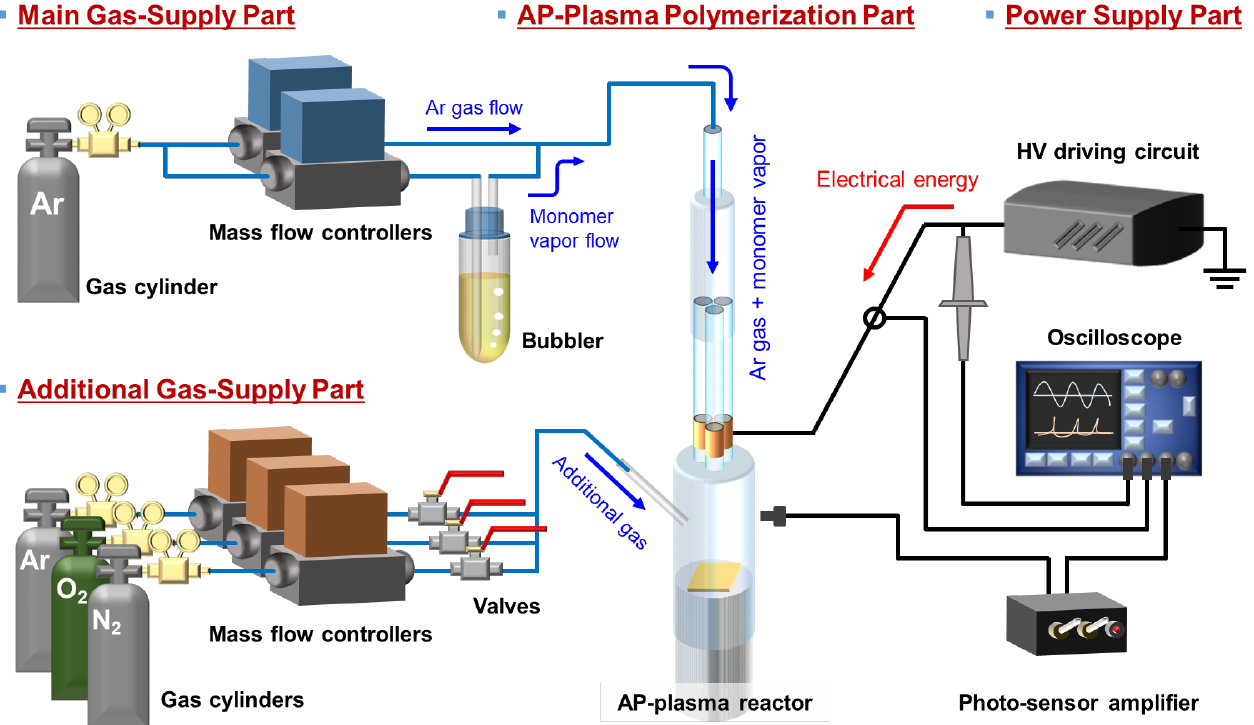
Figure 1. Schematic diagram of the AP plasma polymerization system, equipped with main and additional gas supplies, AP plasma reactor, and HV power supply.